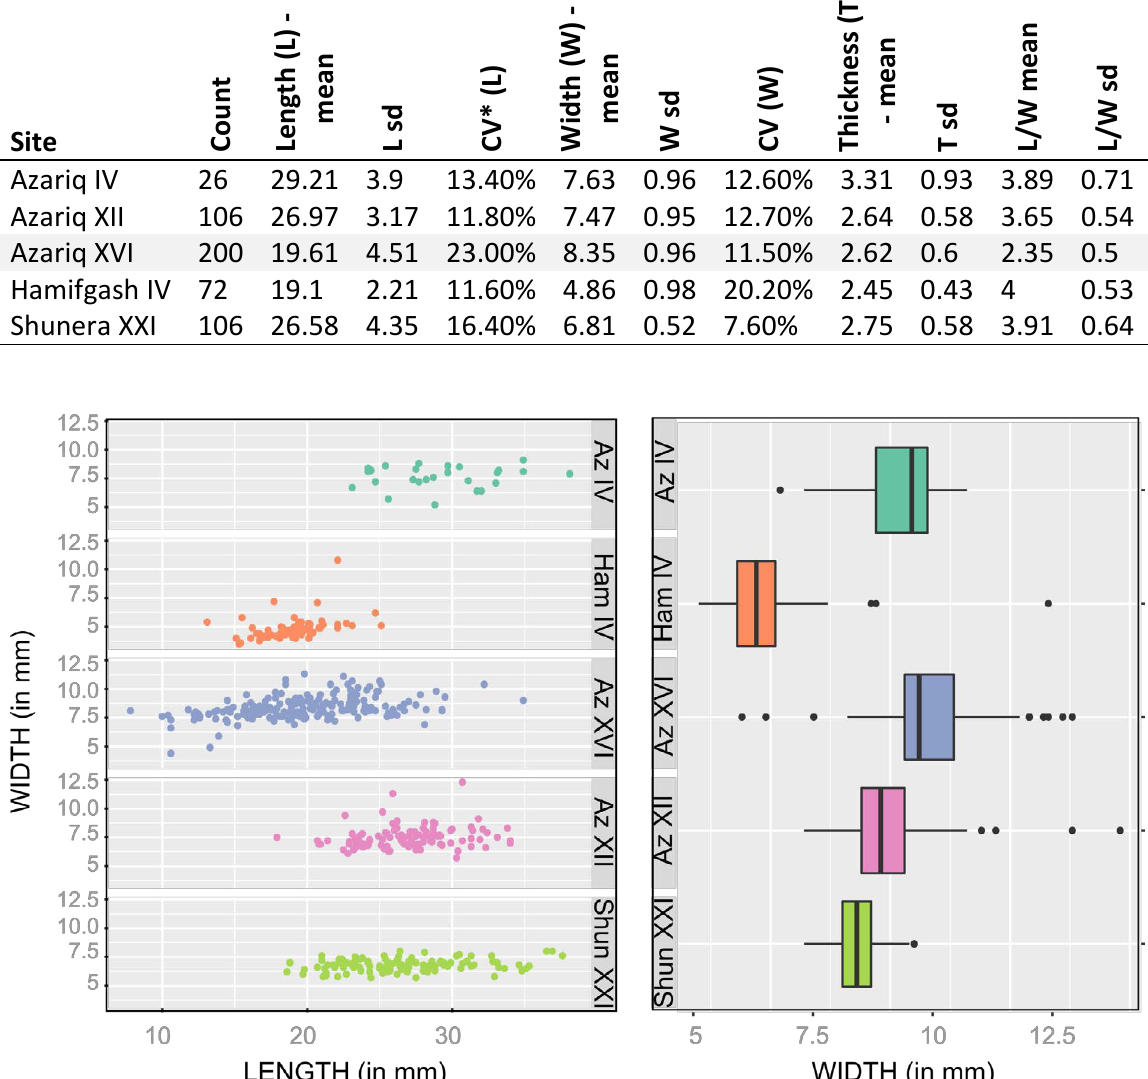
Figure 13. Biplot of lengths and widths and boxplot of widths of complete retouched bladelets. Az - Azariq; Shun - Shunera; Ham -